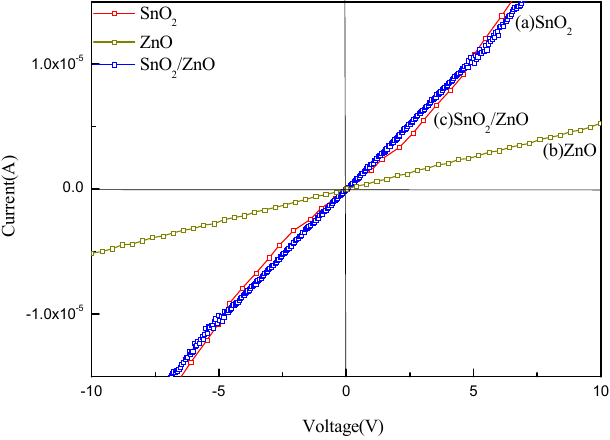
Figure 11. I-V curves of ( a ) the SnO 2 , ( b ) ZnO, and ( c ) SnO 2 /ZnO sensors.